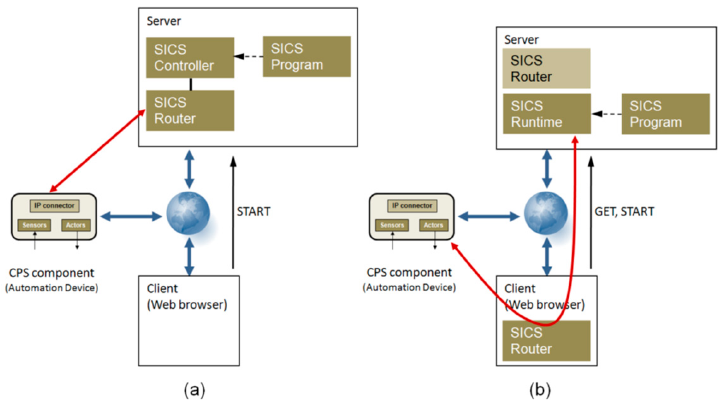
Figure 5. Component structure and communication paths for server-based SICS solutions. ( a ) Server mode (SM); ( b ) server-based mixed mode (SMM).